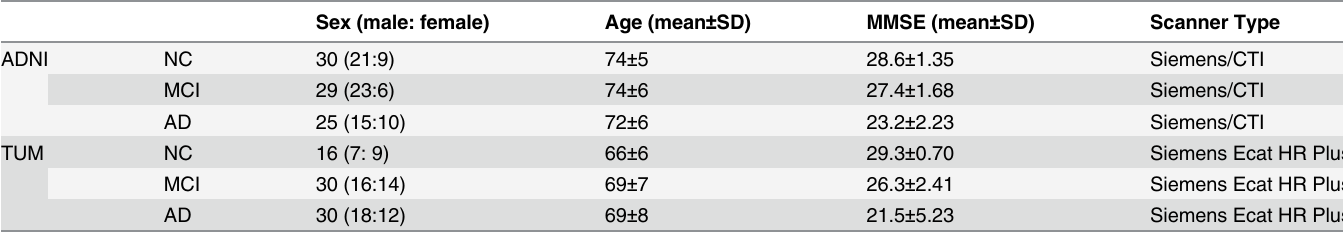
Table 1. Participant characteristics and scanner